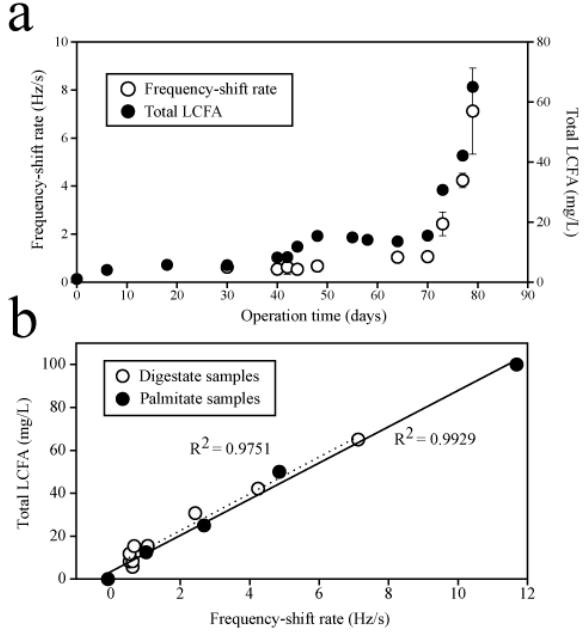
Figure 5. ( a ) Time courses of QCM frequency-shift rates ( n = 3) and LCFA concentrations of anaerobic digestate samples; and ( b ) Comparison of relationships between frequency-shift rates and LCFA concentrations in digestate and palmitate samples. Total LCFA values in Figure 5 are the concentrations of diluted samples before measurements.